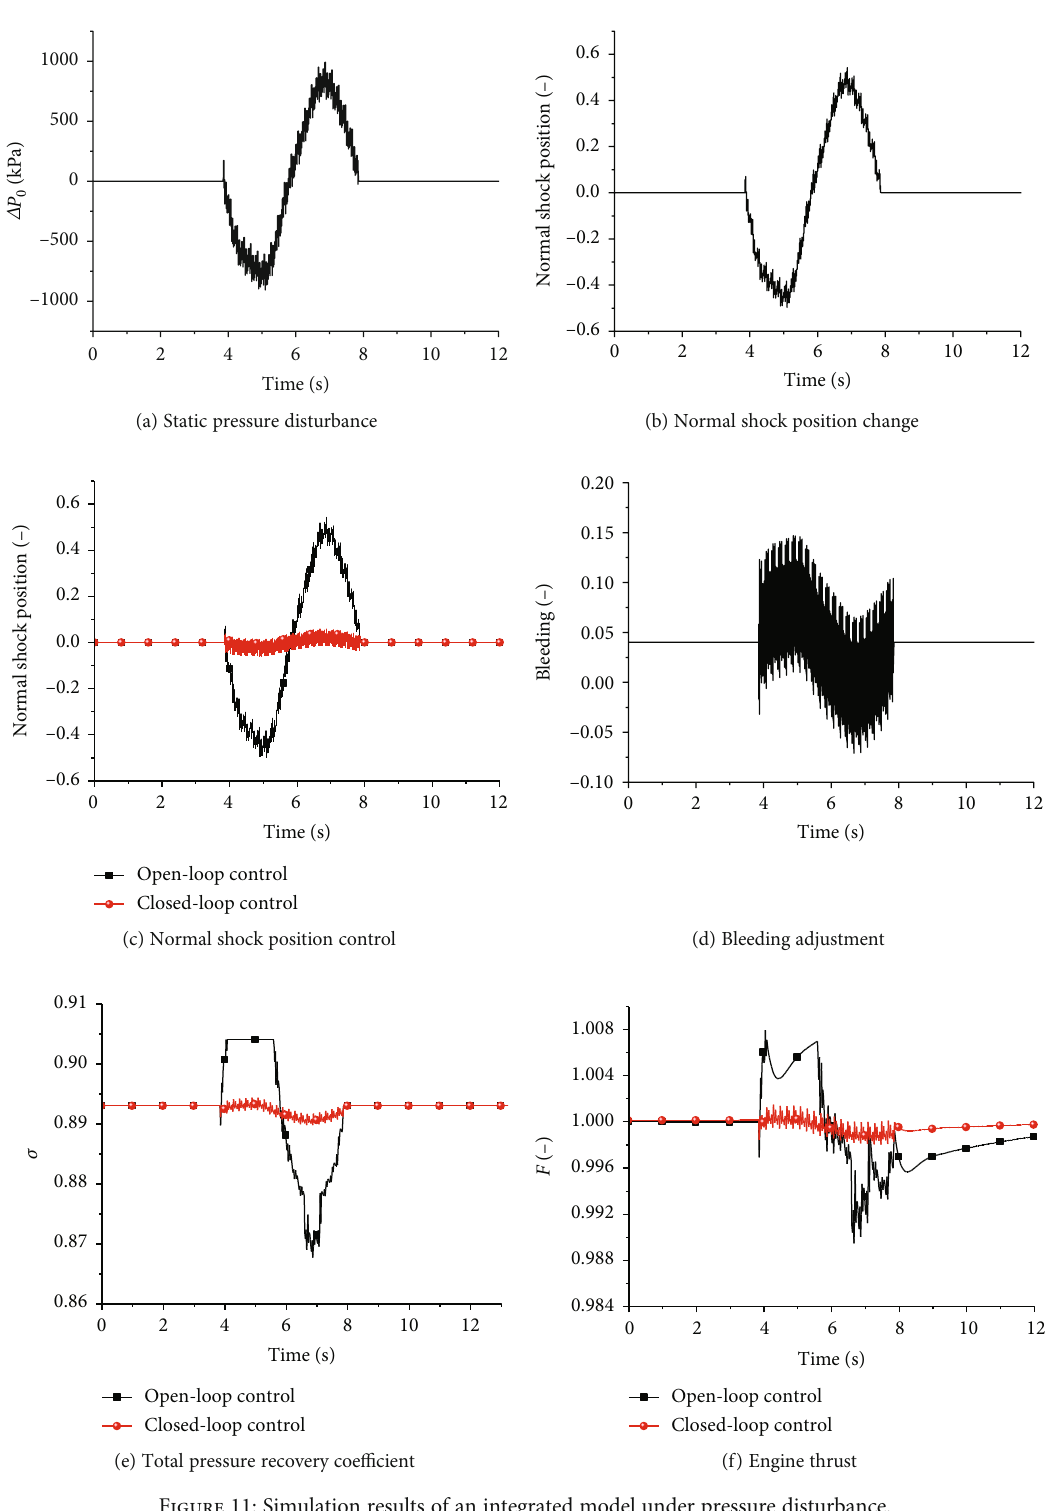
Figure 11: Simulation results of an integrated model under pressure